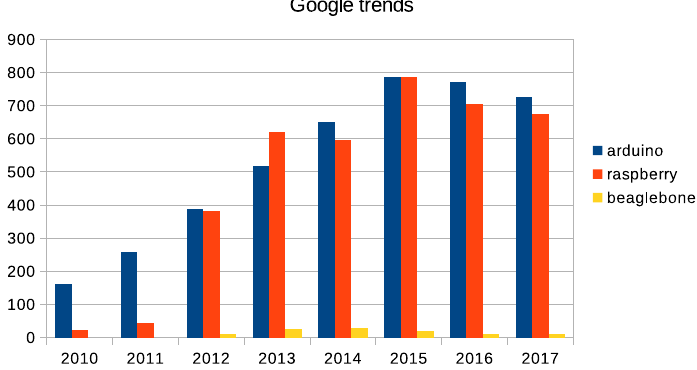
Figure 1. Google trends for Arduino, Raspberri Pi and Beaglebone boards in the last